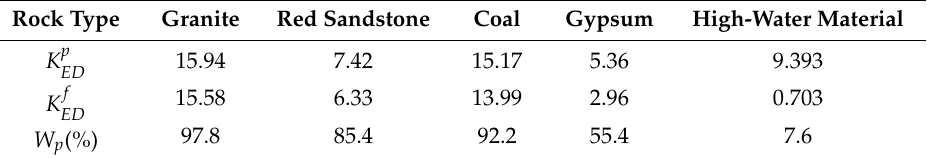
Table 4. The strain energy preservation indices of five rock materials.